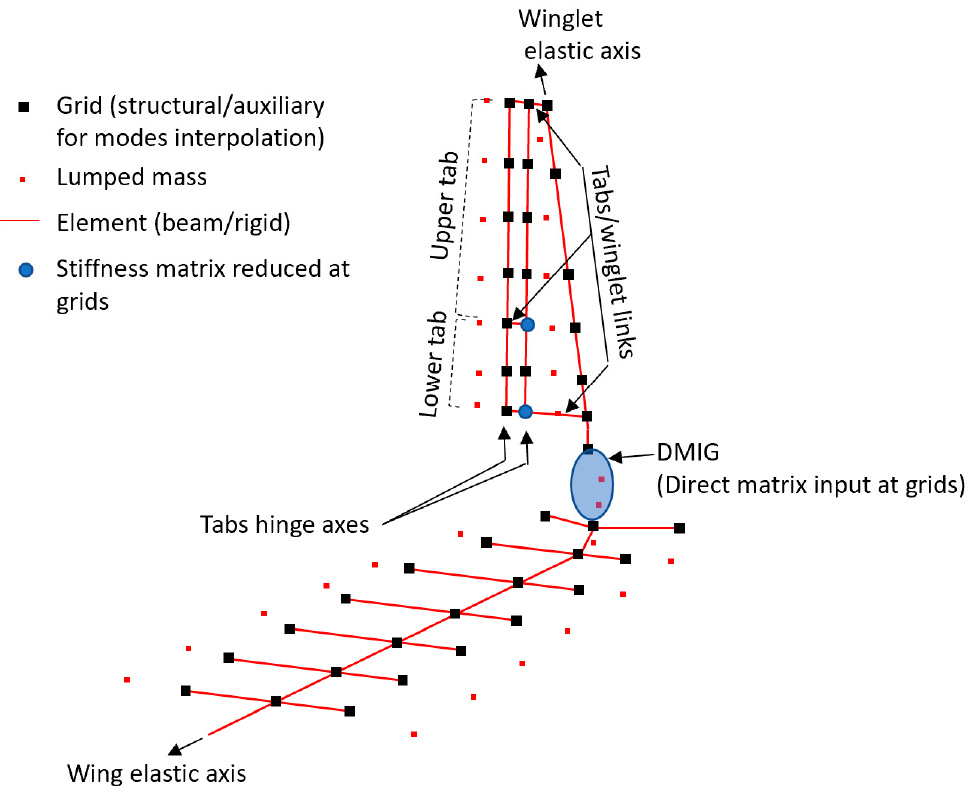
Figure 12. Morphing winglet dynamic model.